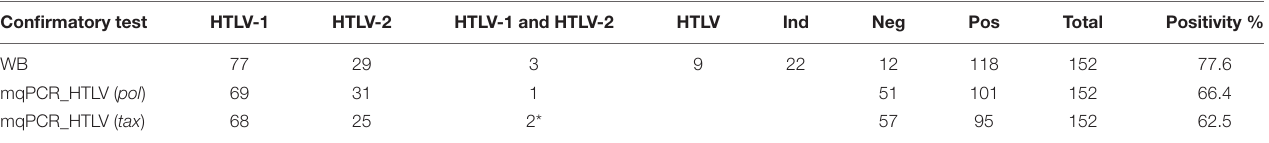
TABLE 6 | Results of HTLV-1/2 confirmatory tests (WB, mqPCR_HTLV pol and tax ) when employed in HIV-infected individuals suspected of HTLV-1/2 infection by screening assays (Group